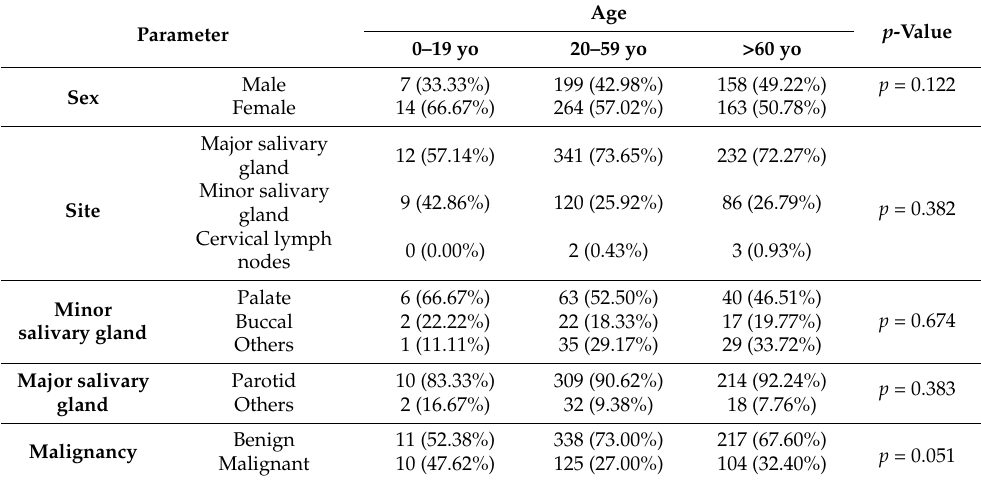
Table 3. Clinicopathological characteristics by